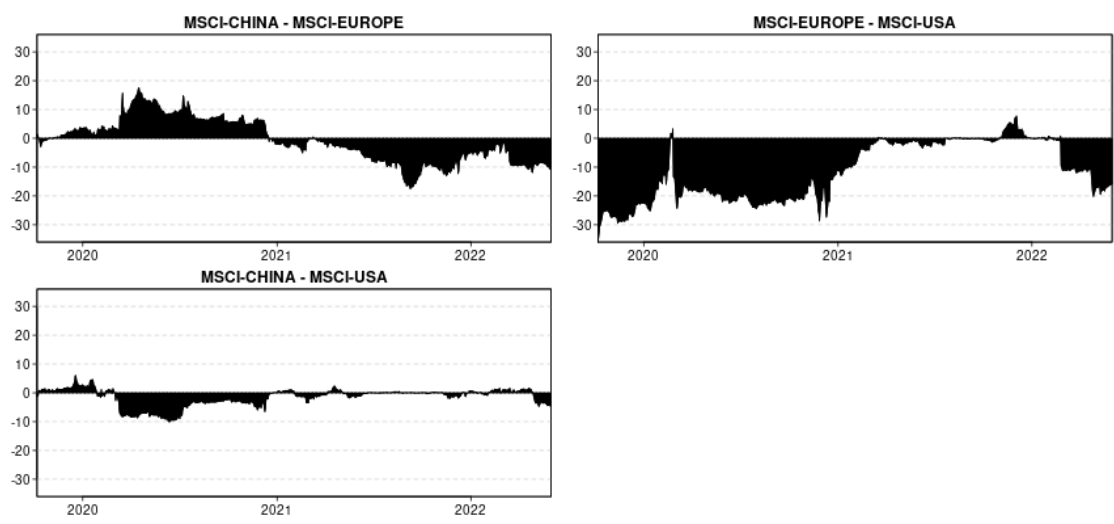
Figure 7. Net volatility spillovers.